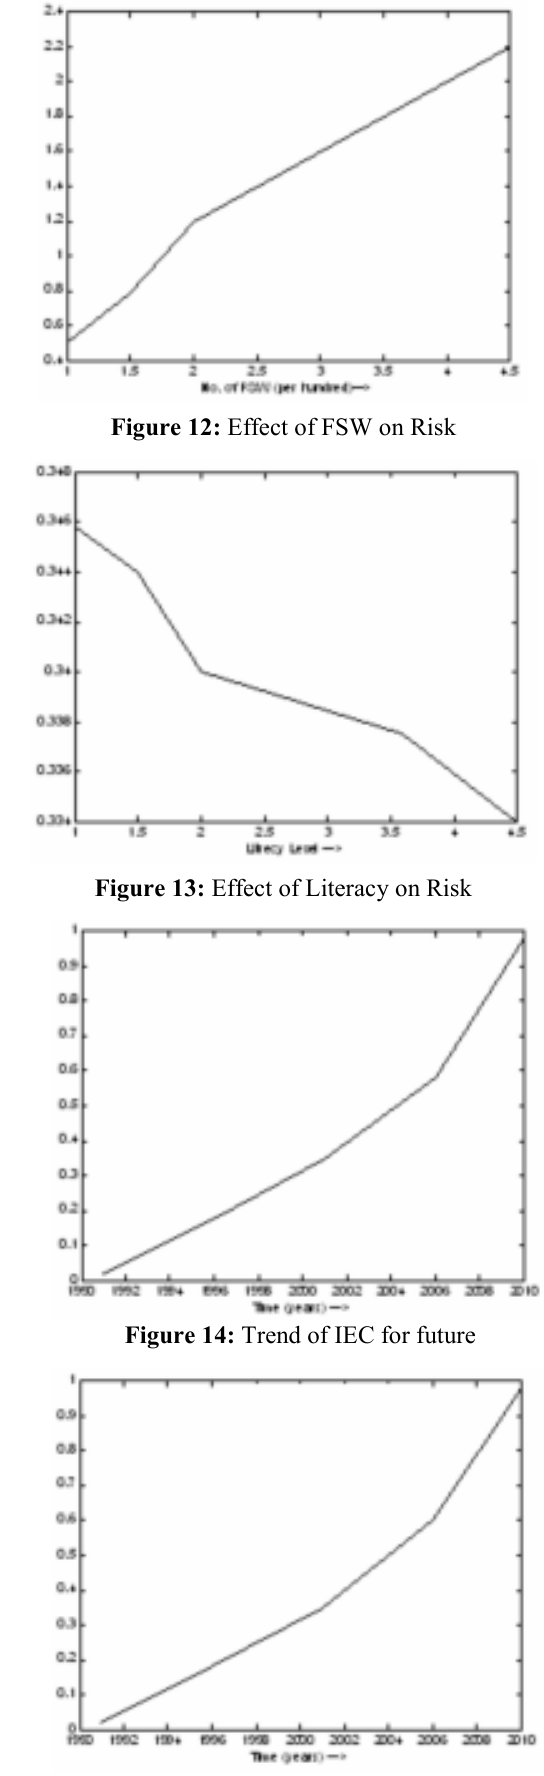
Figure 15: Trend of infected